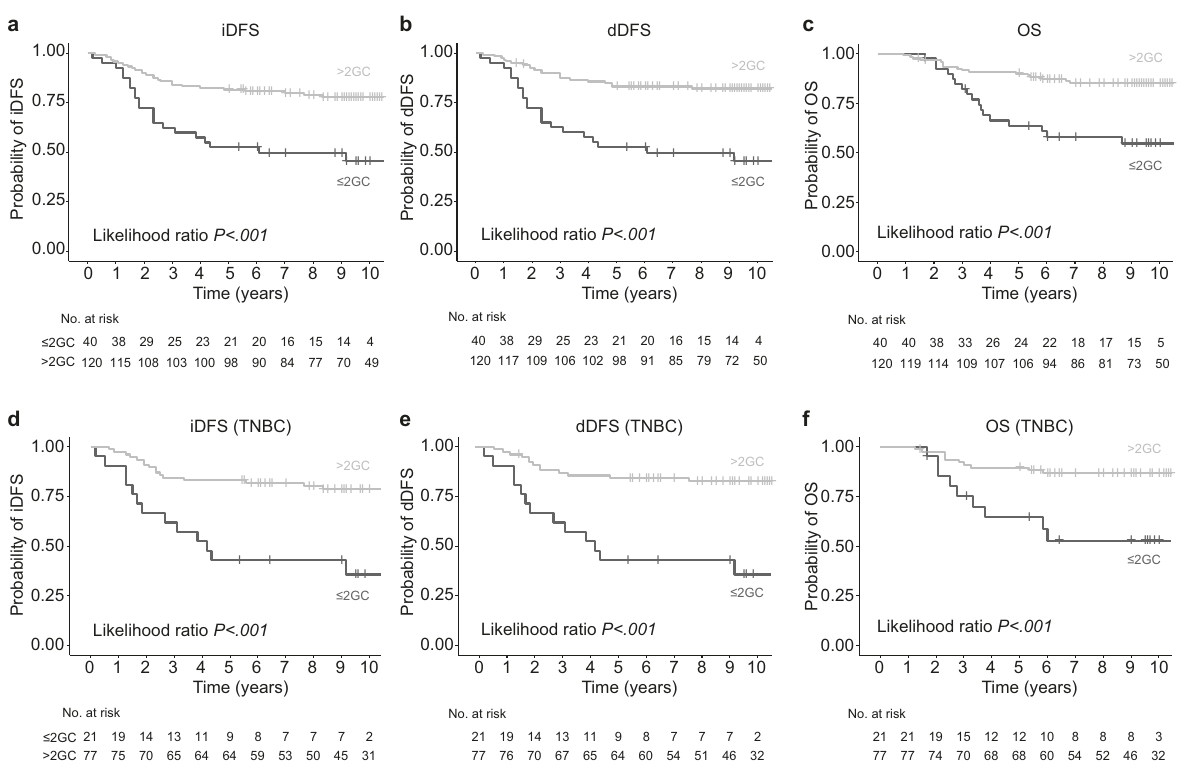
Fig. 3 Kaplan-Meier survival analyses predicting. a invasive Disease-Free Survival (iDFS), b distant Disease-Free Survival (dDFS), c Overall Survival (OS), d invasive Disease-Free Survival (iDFS) in TNBC, e distant Disease-Free Survival (dDFS) in TNBC and f Overall Survival (OS) in TNBC. Patients were dichotomized into those with ≤ 2GCs versus >2 GCs in all assessed cancer-free LNs. P values correspond to likelihood ratio